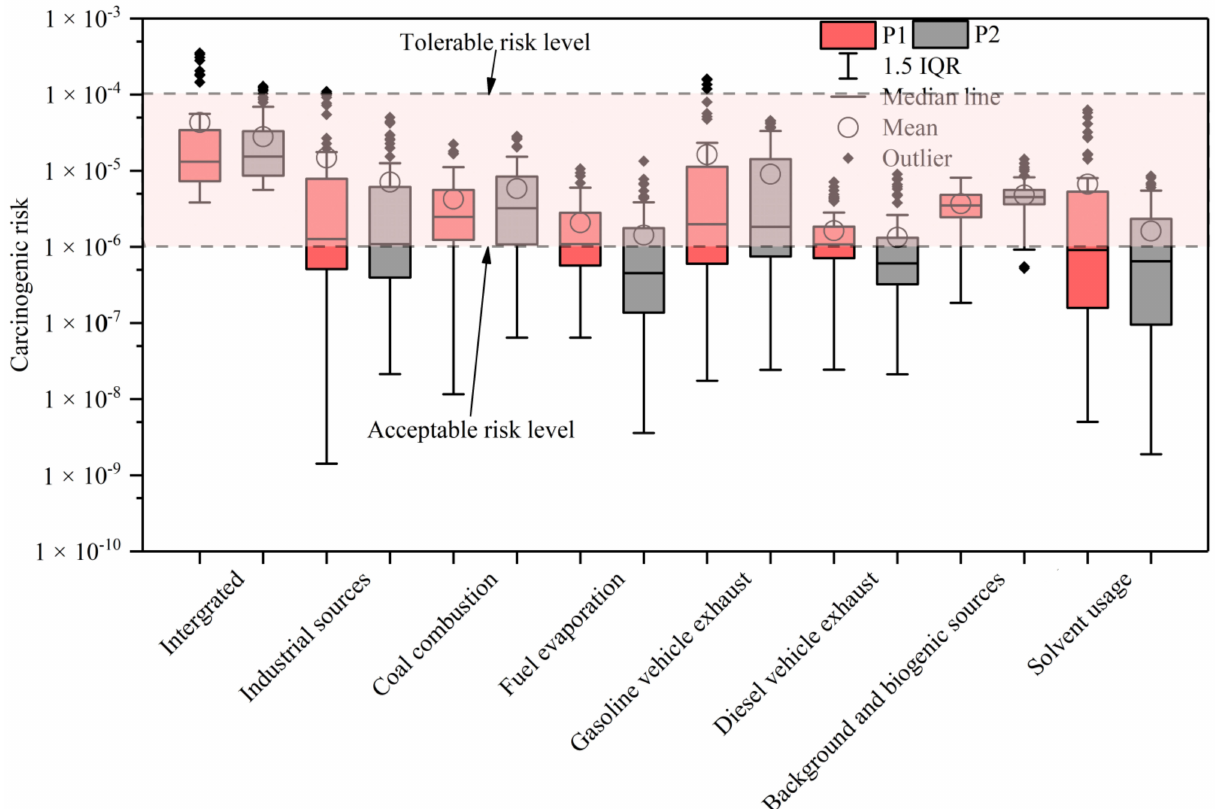
Figure 8. Carcinogenic risks of PMF-derived VOC